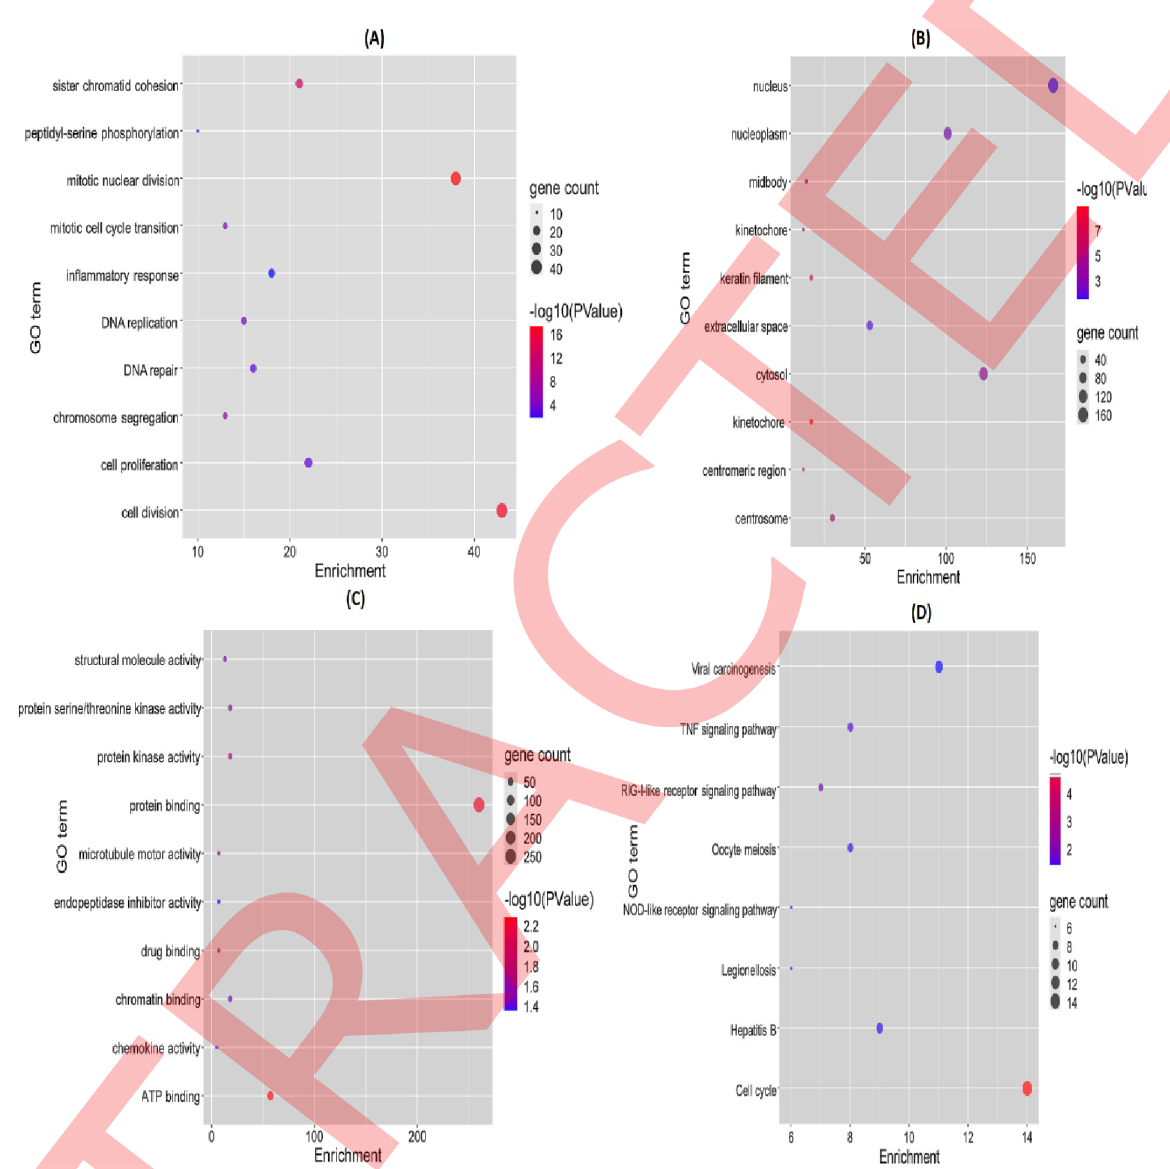
Fig 2. Representation of GO enrichment and KEGG pathway analysis. (A) Gene ontology in terms of BP (B) Gene ontology in terms of CC (C) Gene ontology in terms of MF(D) KEGG pathway analysis.